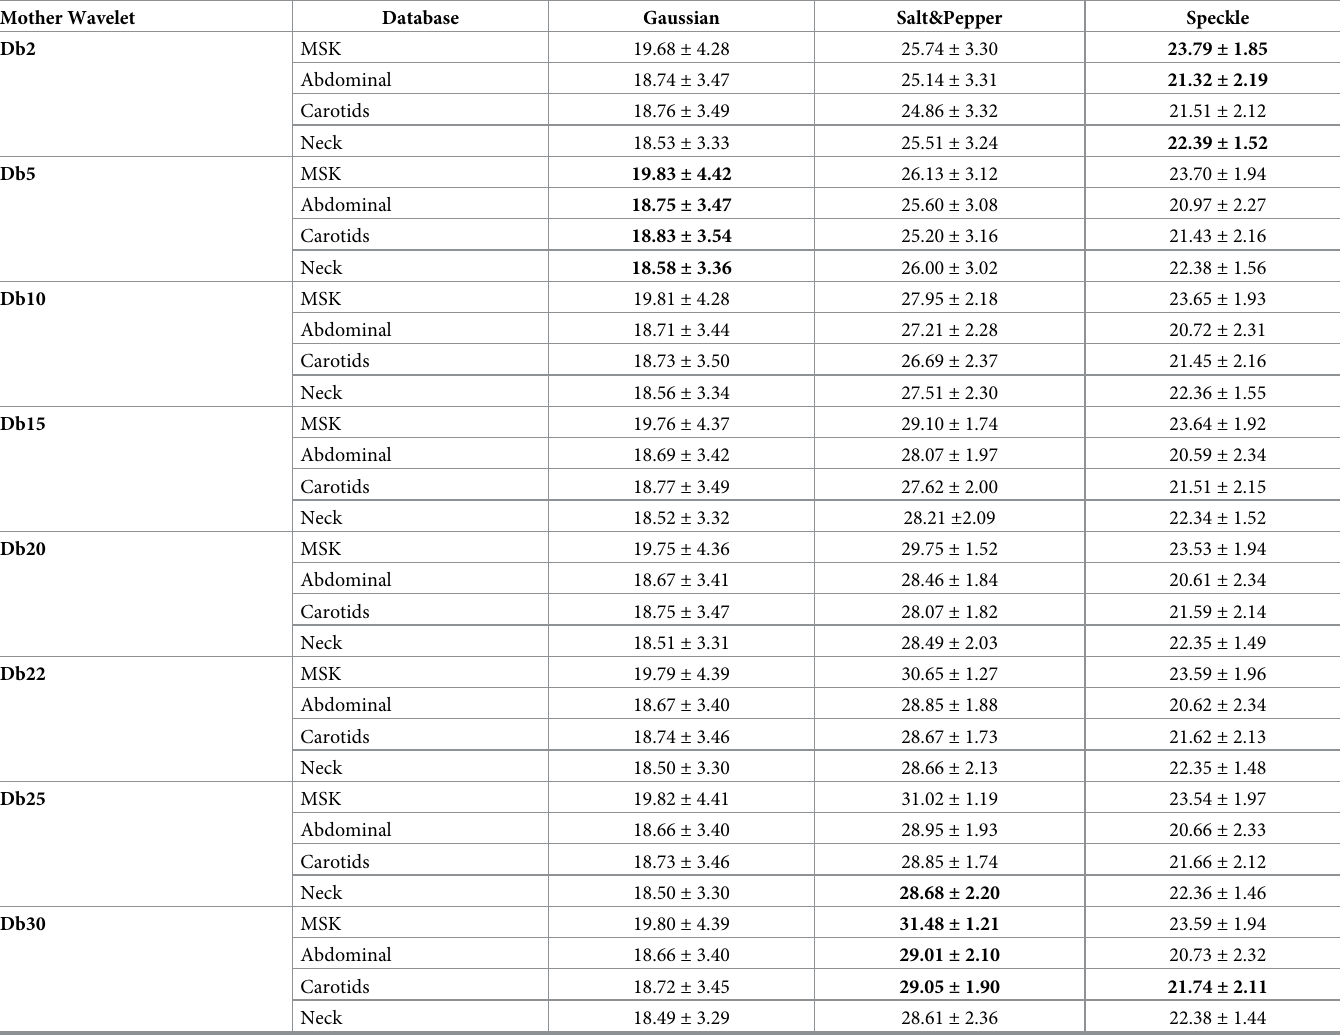
Table 6. Mean comparison of PSNR for Daubechies family with decomposition level 3 and various noise levels and datasets. Mother